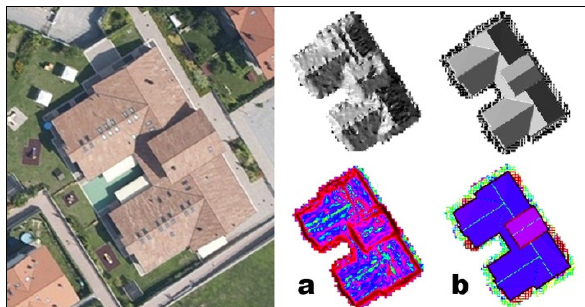
Figure 7 – Comparison between rasters at 25 cm resolution of the same building, presented in the left image: aspect (top) and slope (bottom) maps of the same building obtained from photogrammetry: automatic matching (a) and manual reconstruction (b). Legends for aspect and slope are as in Figure